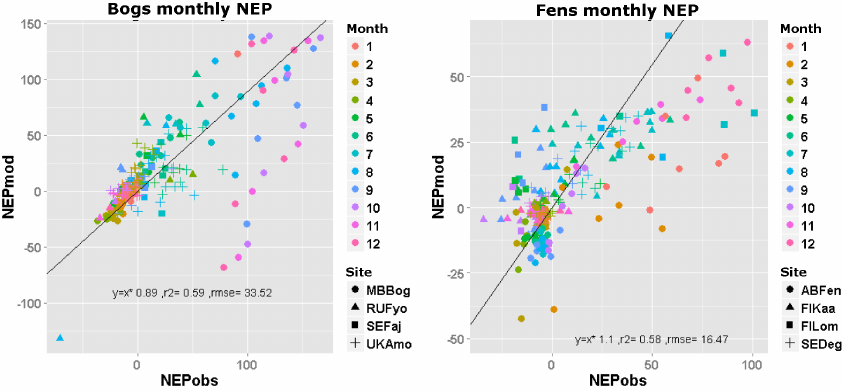
Figure 15. Scatter plots of simulated and observed monthly mean NEP (gCm − 2 month − 1 ) in bogs and fens. The sites are represented by different symbols and NEP for each of the 12 months is colour-coded. The black line represents the best fit of the modelled NEP and the observed